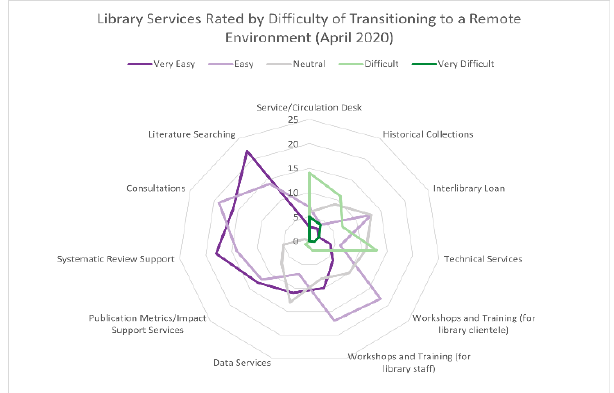
Figure 1b Radar chart of library services rated by difficulty of transitioning to a remote environment in April 2020. The radar chart does not include data for non-responses to highlight better the levels of difficulty for each service